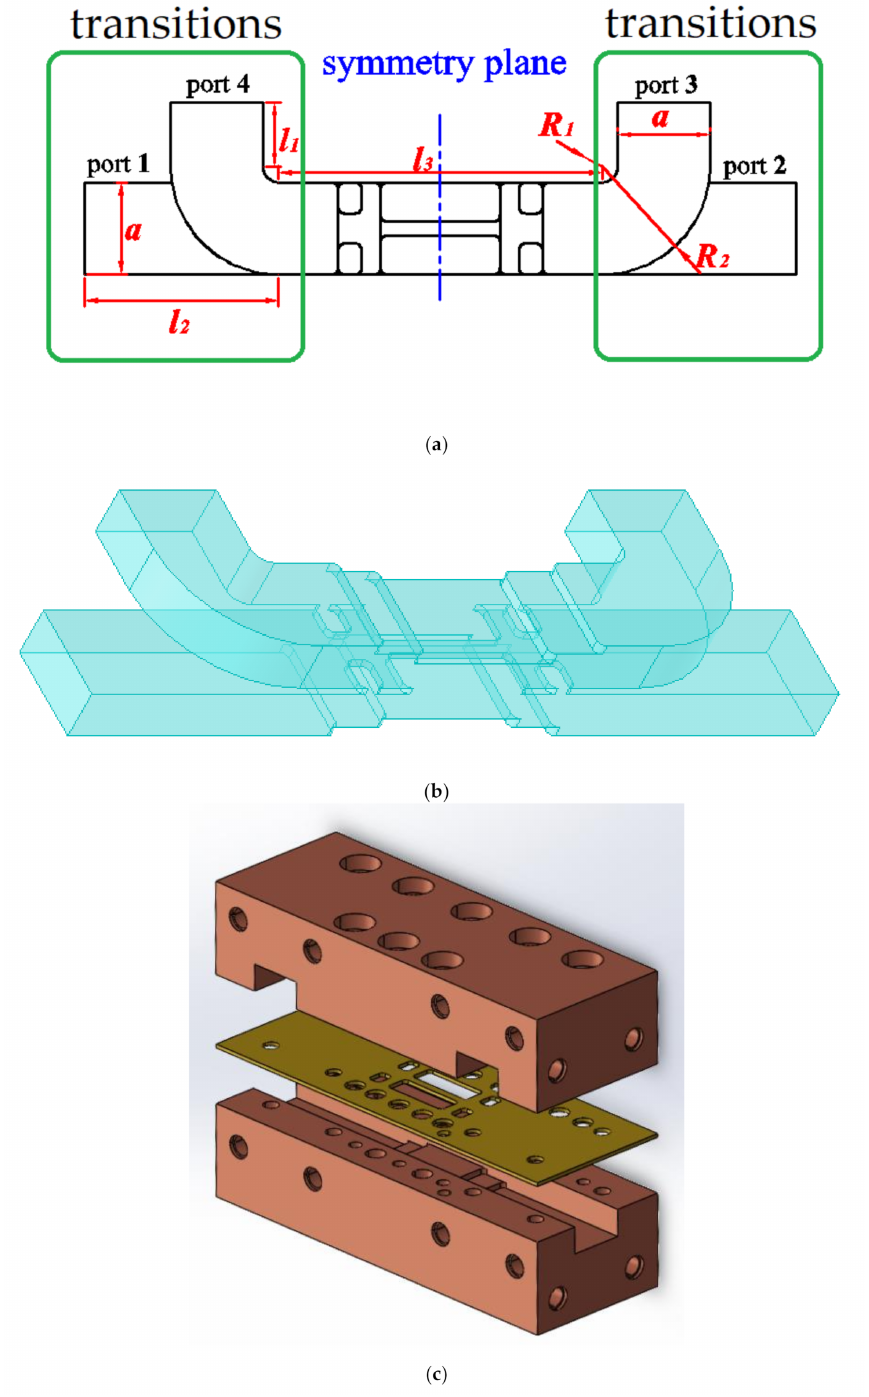
Figure 5. Prototype coupler ( a ) with transitions, ( b ) the 3D-structure diagram, and ( c ) ex- ploded